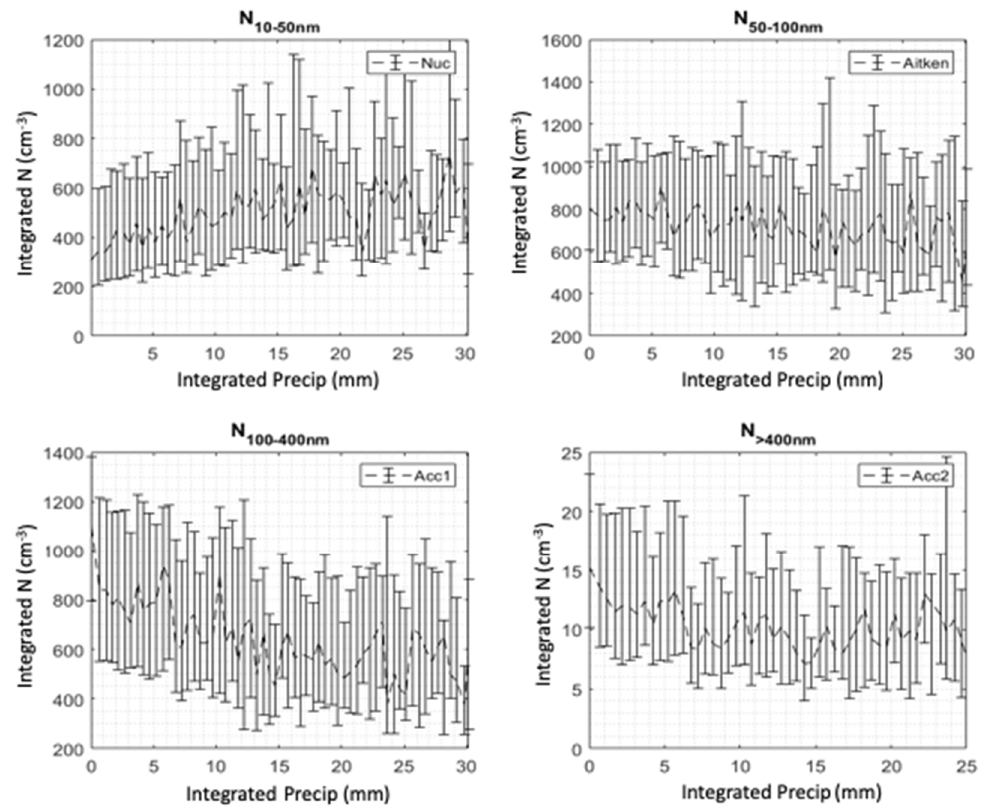
Figure 17. Integrated number concentration over different size and the relation to accumulated precipitation integrated for the last 120 h of transport.